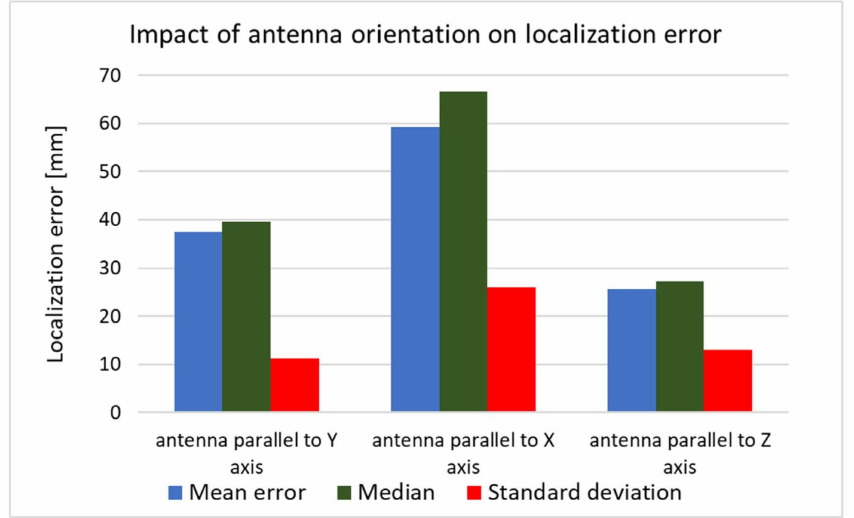
Figure 18. Impact of antenna orientation on localization error obtained in